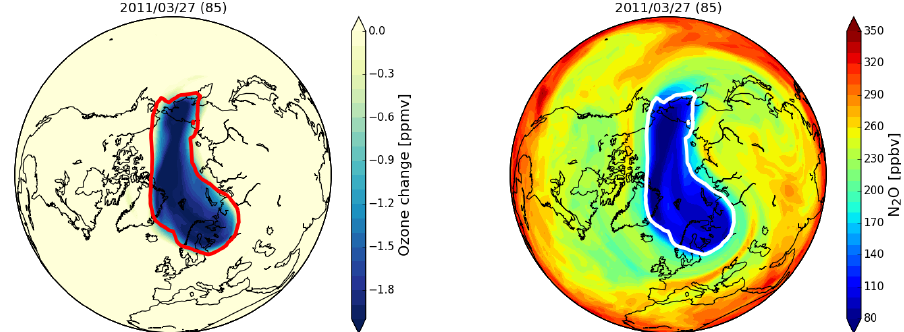
Figure 3. Example of maps of the estimated ozone loss (left panel, in ppmv) and of N 2 O assimilated fields (right panel, in ppbv). Both maps show the average volume mixing ratio in the lower stratosphere (vertical range 425–500K) on 27 March 2011, which corresponds to the time and place where the maximum ozone loss occurred. Red and white contour lines indicate the polar vortex border (EQL of 70 ◦